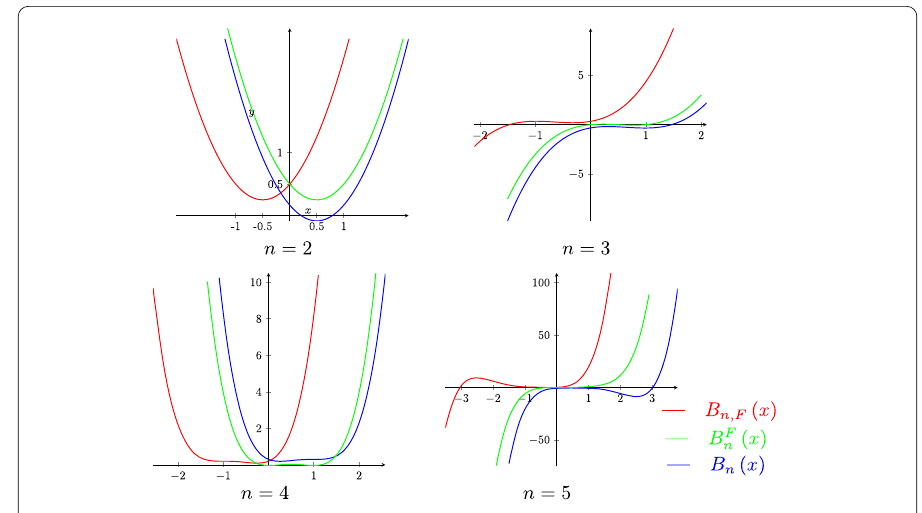
Figure 1 Graphs of B n , F ( x ), B F n ( x ) and B n ( x ) for n =